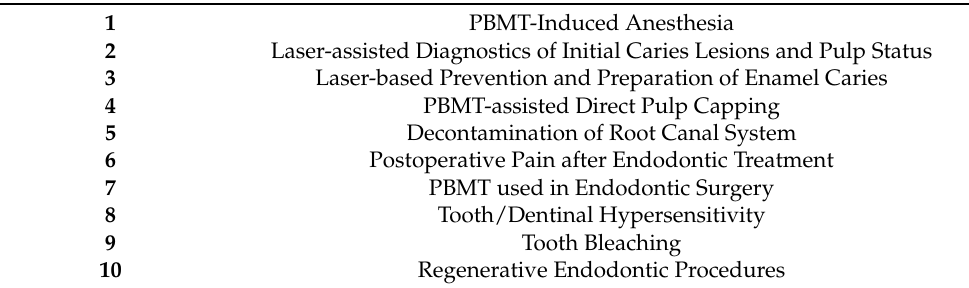
Table 1. Current applications of PBMT in